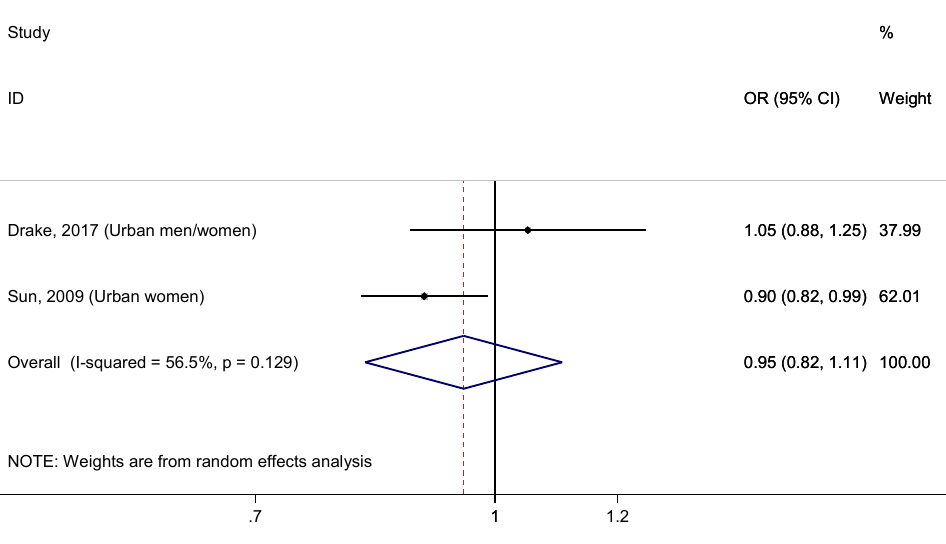
moderate heterogeneity between the studies (I 2 = 56.5%, p = 0.129). Moreover, no evidence of publication bias was found ( p = 1.000) (Supplementary Materials Figure S3).